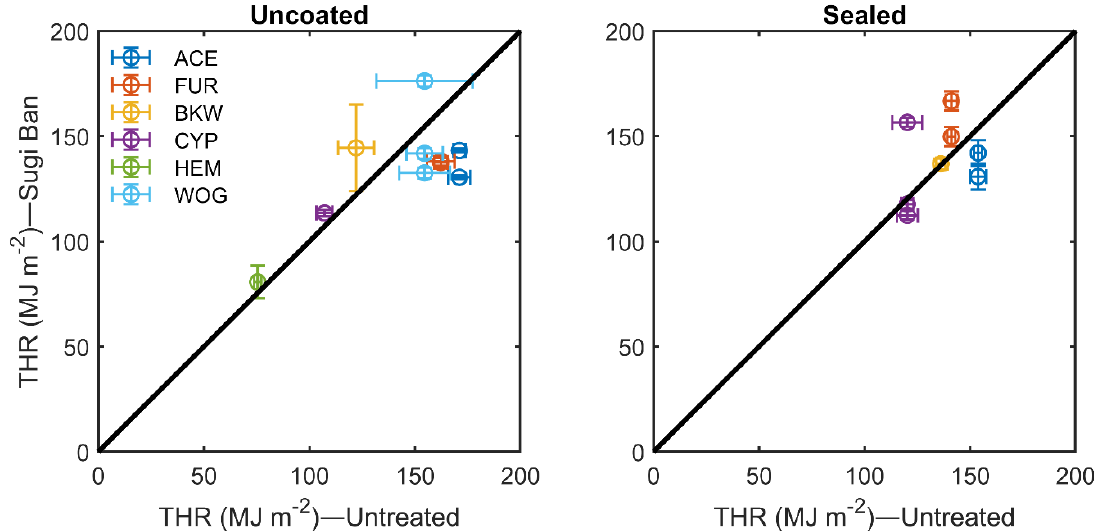
Figure 8. Comparison of the total heat released (THR) between the untreated and charred wood specimens for both the uncoated and sealed specimens. The error bars represent the standard deviation.